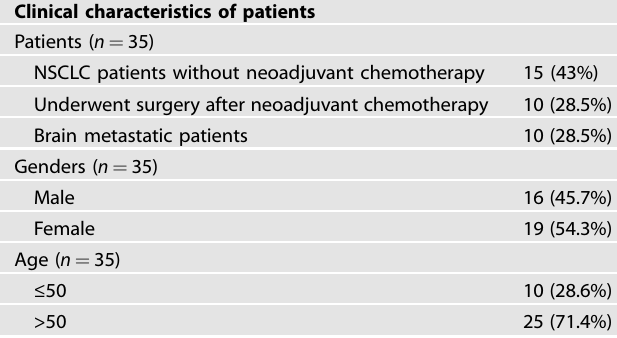
Table 1. Clinical characteristics of 35 patients. Clinical characteristics of